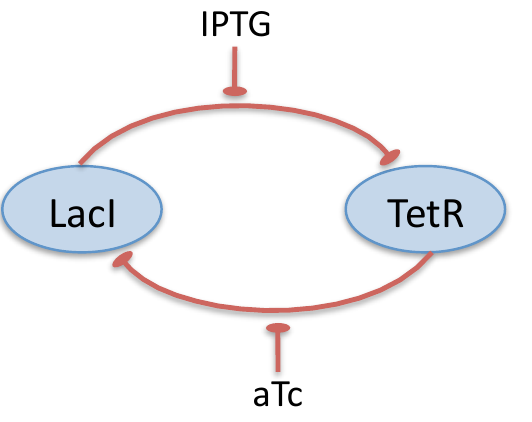
Figure 23: Conceptual diagram of LacI/TetR toggle switch: the LacI and TetR transcription factors are arranged to mutually repress each other’s expression, creating a bi-stable system. Transition between the two states is triggered by the small-molecule signals aTc (which disrupts TetR repression) and IPTG (which disrupts LacI repression).